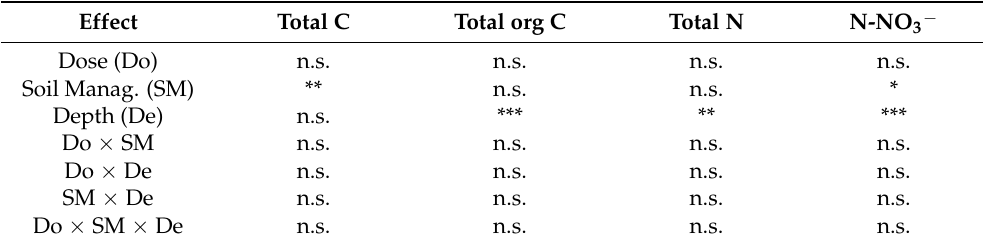
Table 5. Effects of the fertigation dose (Do), soil management (SM) and the soil depth (De) and its interactions on the total soil carbon (Total C), total soil organic carbon (Total org C), total soil N (Total N) and soil N-NO 3 − concentration.